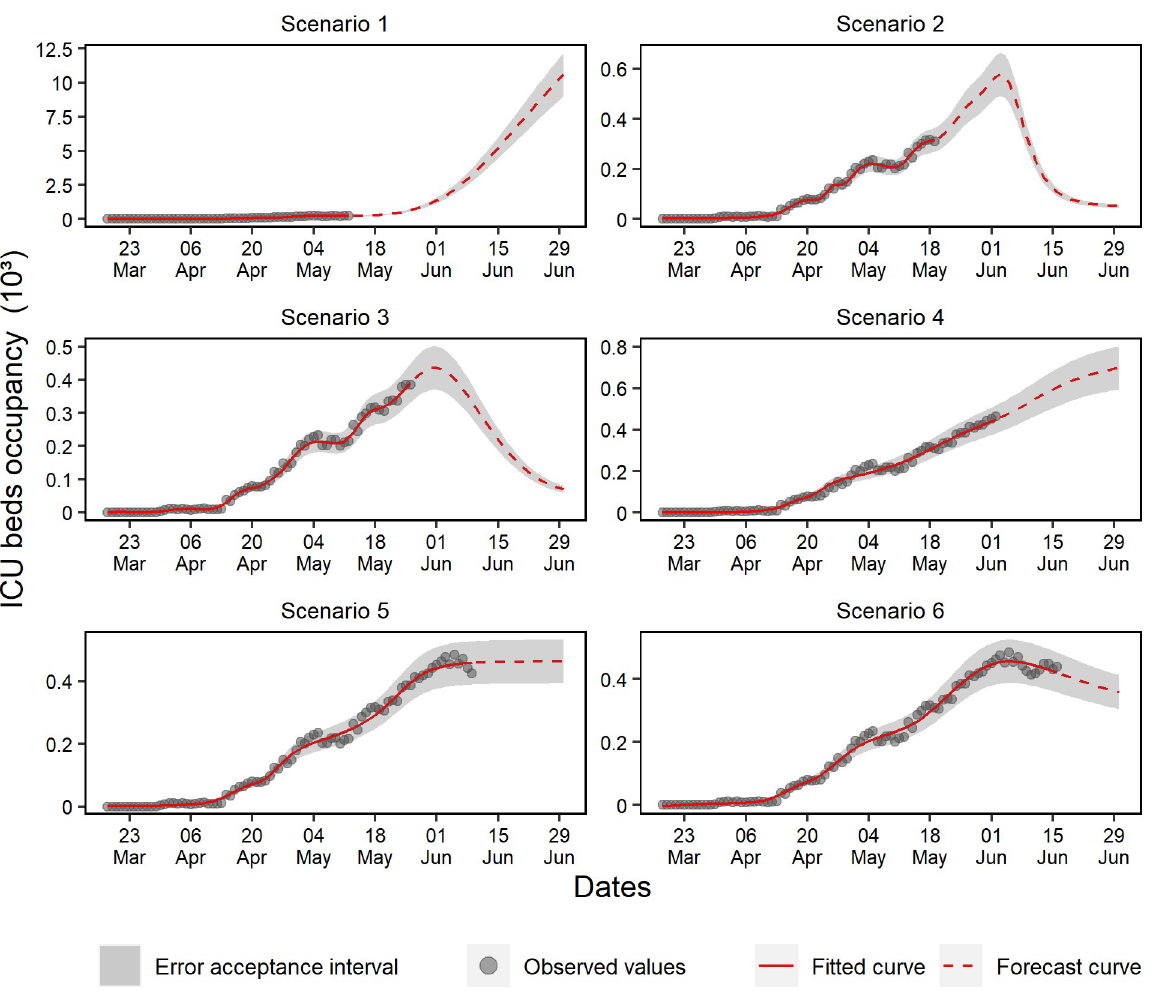
Fig 9. Forecasting of ICU beds occupancy in the six analyzed